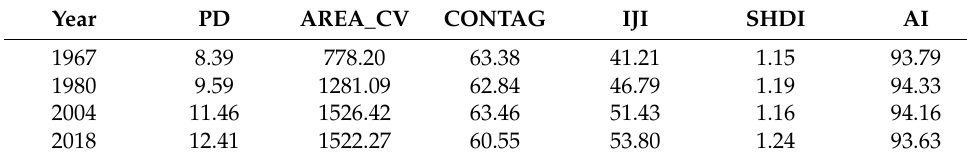
Table 7. Landscape pattern index changes at the landscape level.